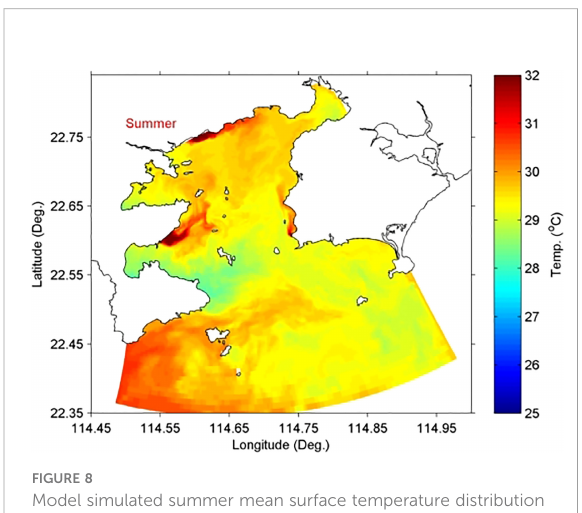
FIGURE 8 Model simulated summer mean surface temperature distribution in the Daya Bay.